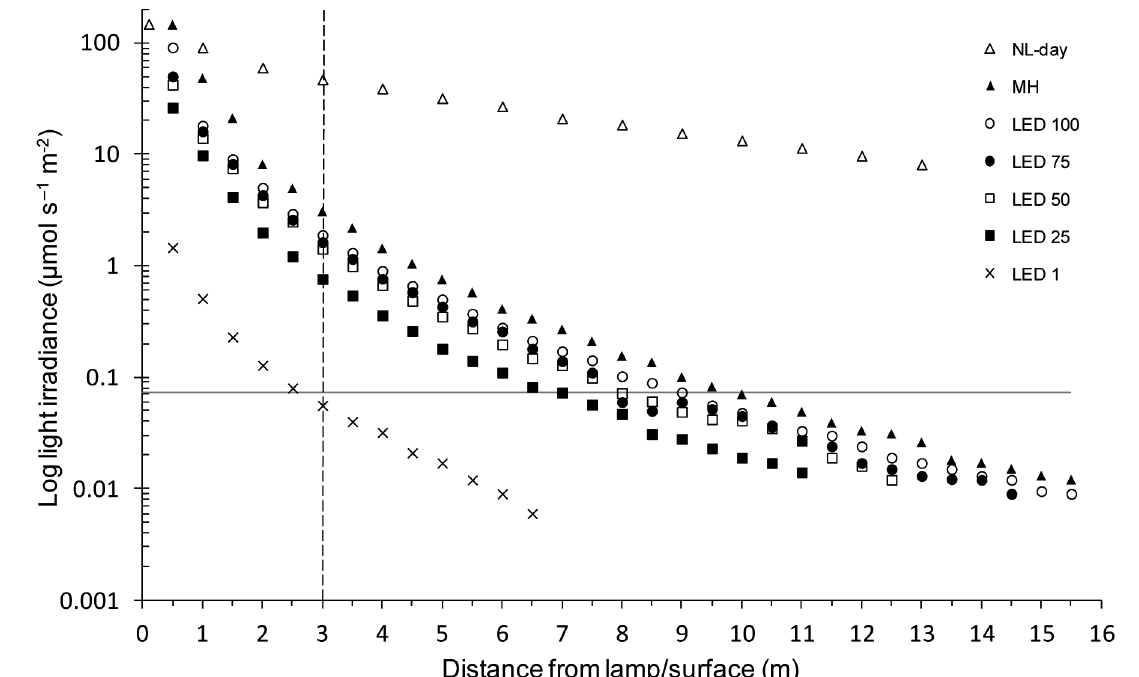
Fig. 3. Horizontal profile of light-attenuation generated by the LED and metal halide (MH) lamps measured on a night with no moon. The light intensity at different depths on a clear day, but with no direct sunlight, is included for comparison (NL-day). The horizontal line is the irradiation necessary to reduce plasma melatonin to daytime levels (see Migaud et al. 2006); the vertical line shows the irradiance values used in the correlation analysis (Fig.